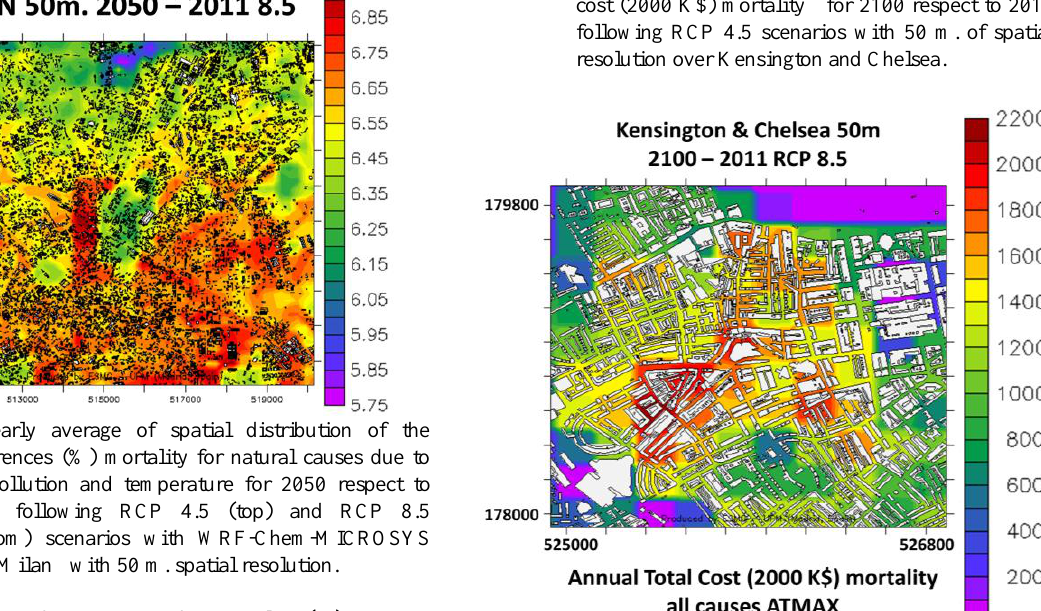
Figure 4. Spatial distribution of the differences in annual total cost (2000 K$) mortality for 2100 respect to 2011 following RCP 8.5 scenarios with 50 m. of spatial resolution over Kensington and